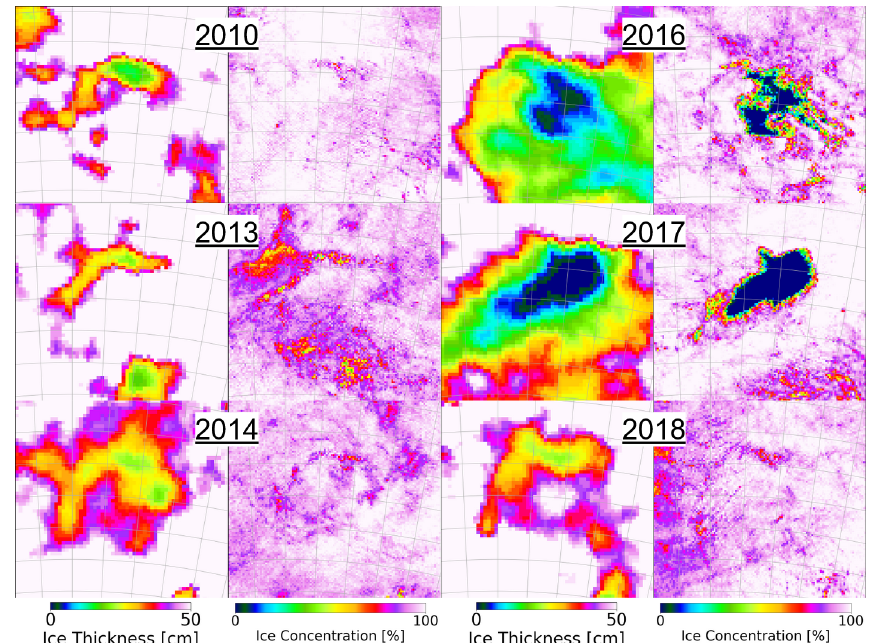
Figure 7. ASI SIC and SMOS ASIT retrieval maps covering all major thinning events that can be seen in the 11-year SMOS record (Fig. 2). All maps cover the area of interest outlined in Fig. 1 with all the grid lines remaining identical (removed here to maximize the size of each